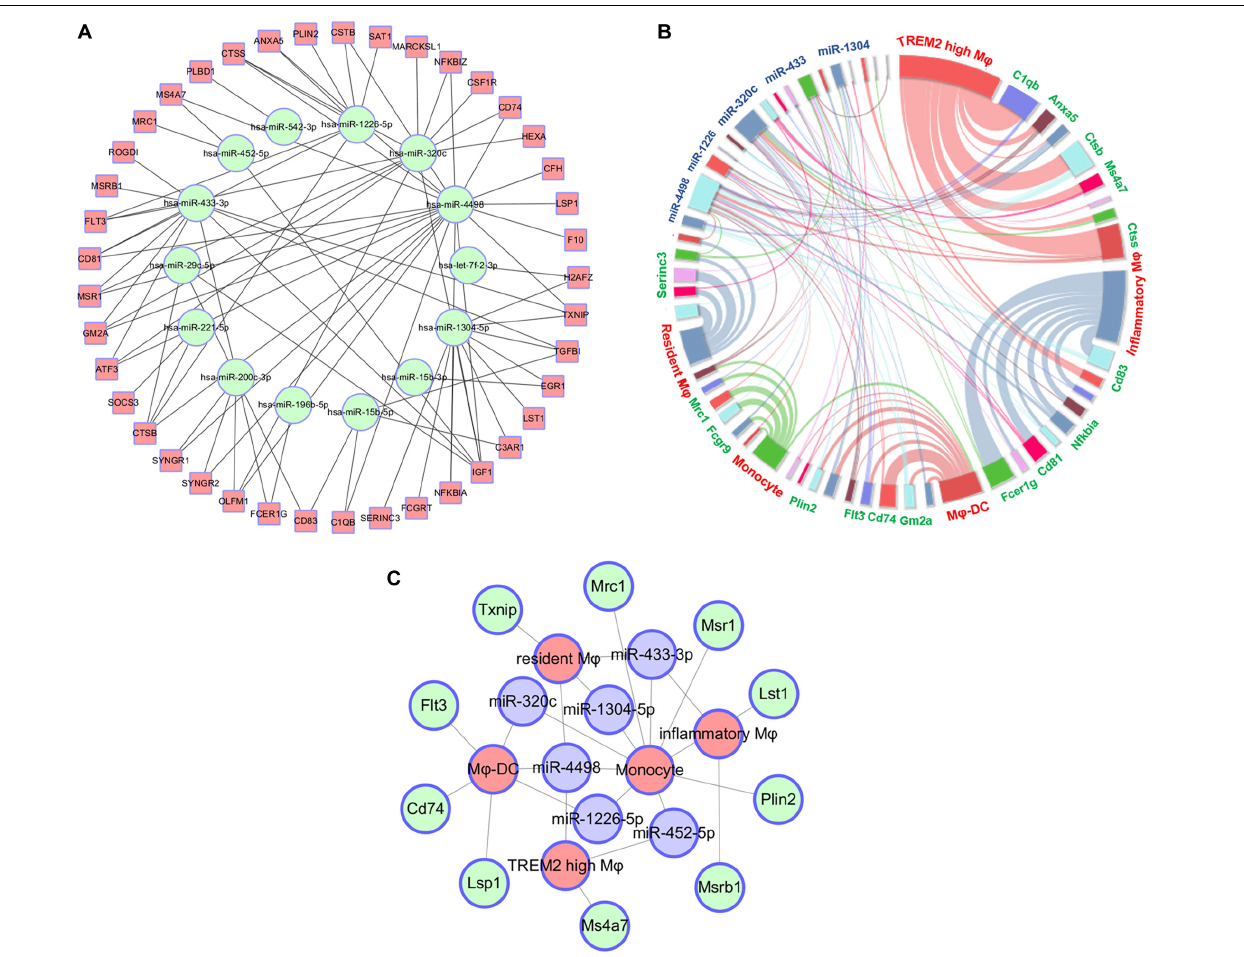
FIGURE 4 | Construct of interacted network of RNAs and monocyte-related populations. (A) The co-expression networks based on the screening of miRNA–mRNA pairs. (B) Highchart showing the relationships between miRNAs, mRNA, and five monocyte-related clusters. (C) The interacted network constructed by the key six miRNAs, 10 mRNAs, and five monocyte-related